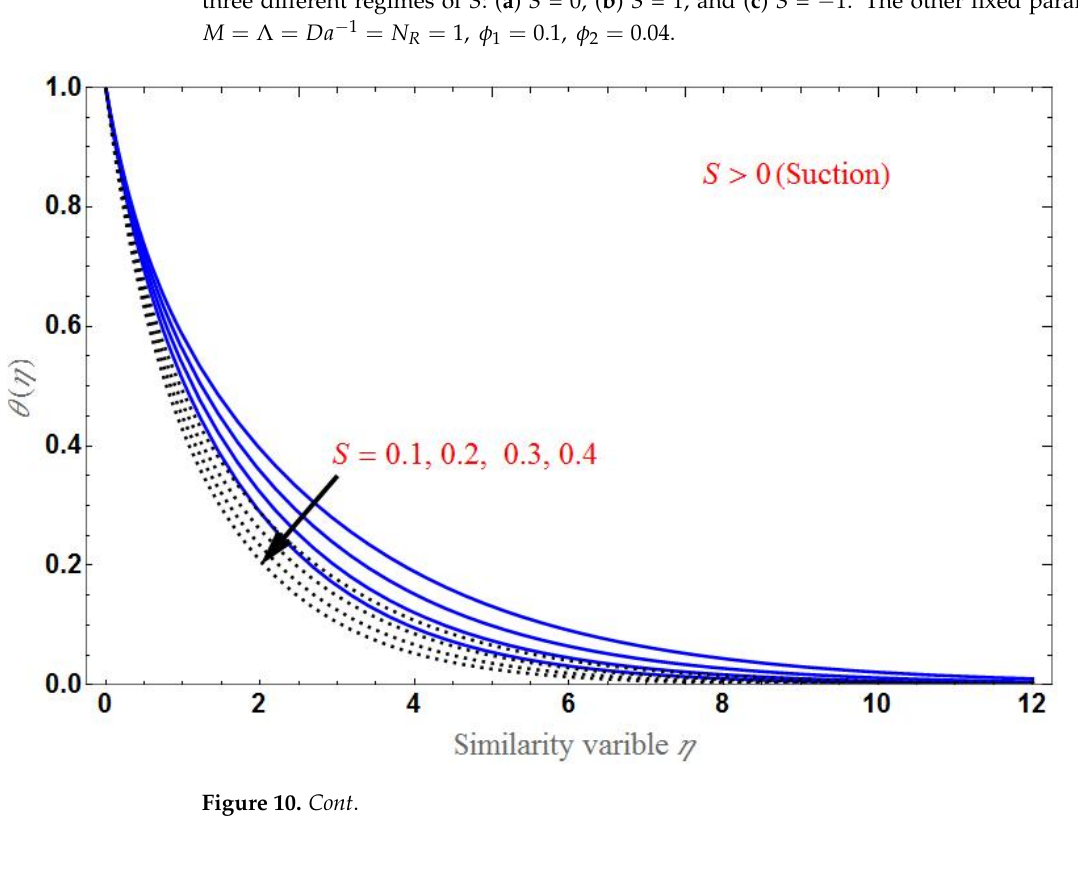
Figure 9. The temperature distribution for three different regimes of S : ( a ) S = 0, ( b ) S = 1, and ( c ) S = − 1. The other fixed parameters are: